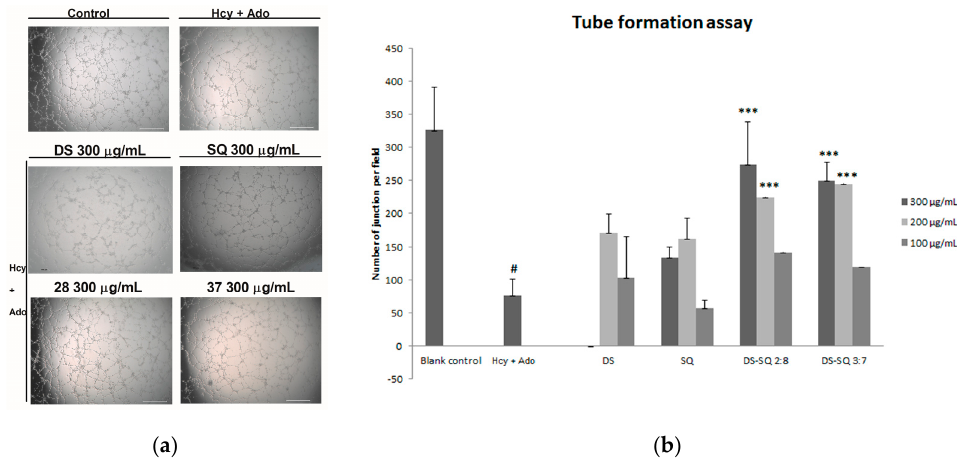
Figure 3. Effects of DS, SQ, DS-SQ 2:8 and DS-SQ 3:7 on angiogenic activities in EAhy 926 cells induced by Hcy and Ado. ( a ) Photo view of blank, Hcy + Ado and DS, SQ, DS:SQ 2:8 and DS:SQ 3:7 at 300 µg/mL on tube formation in EAhy 926 cells; ( b ) Statistical analysis of number of junction per field for each sample, generated by angiogenesis analyzer, Image J. All results were expressed as mean ± SD from over three independent experiments. # p < 0.05 Hcy + Ado stimulation compared with blank control. * p < 0.05 compared with Hcy + Ado stimulation. *** p < 0.001 compared with Hcy + Ado stimulation.